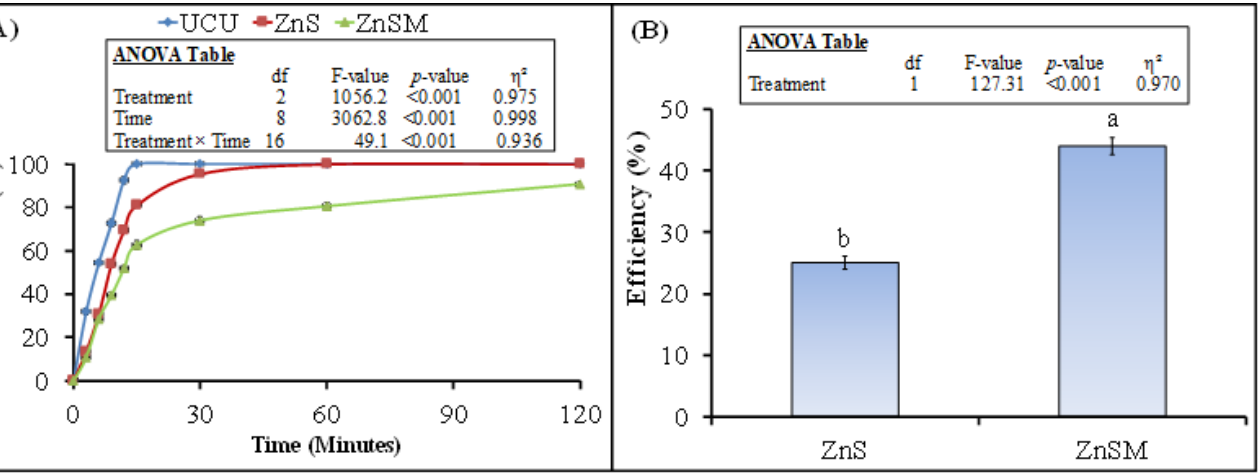
Figure 3. Urea release rate (%) ( A ) and its efficiency ( B ) from uncoated and zinc sulphate (ZnS) and zinc sulphate plus molasses (ZnSM) coated urea. Different small letters in Figure 3B show significant difference between treatments at 5% probability level. Inset represents ANOVA table. The comparison among treatments was analyzed by T-test.